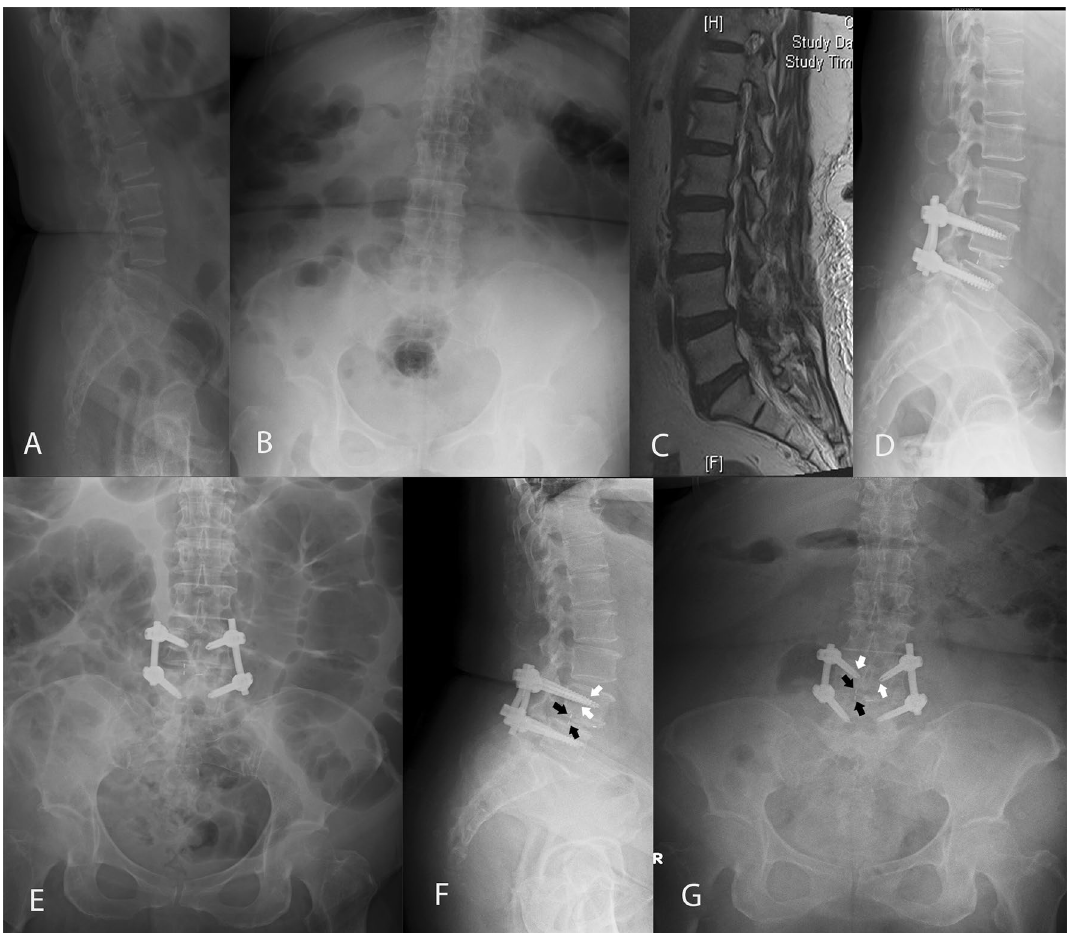
Figure 1. A patient was diagnosed preoperatively with degenerative spondylolisthesis and lumbar spinal stenosis at L4-5 level, and underwent minimally invasive transforaminal lumbar interbody fusion (MIS-TLIF). Radiographic images ( A , B ) and MRI ( C ) were taken preoperatively. The immediate post-operative lumbar spine lateral view ( D ) and lumbar antero-posterior view ( E ) are shown. Cage subsidence (black arrow) and screw halo sign (white arrow) were seen on the last follow-up images ( F , G